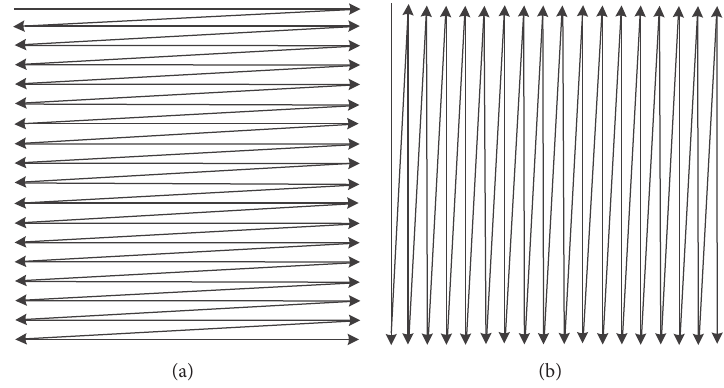
Figure 2: Scanning order for 16 × 16 macroblock. (a) horizontal raster scan [2]. (b) vertical raster scan.